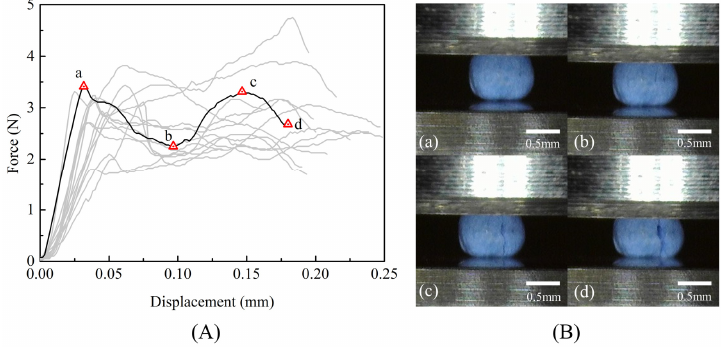
Figure 4. Experimental results of single particle crushing tests: ( A ) force–displacement curves; 4 ( B ) particle state during the loading process. ( a ) elastic limit; ( b ) yield minimum; ( c ) breakage peak; ( d ) finial failure.